Question: Give a one-sentence summary of this figure.
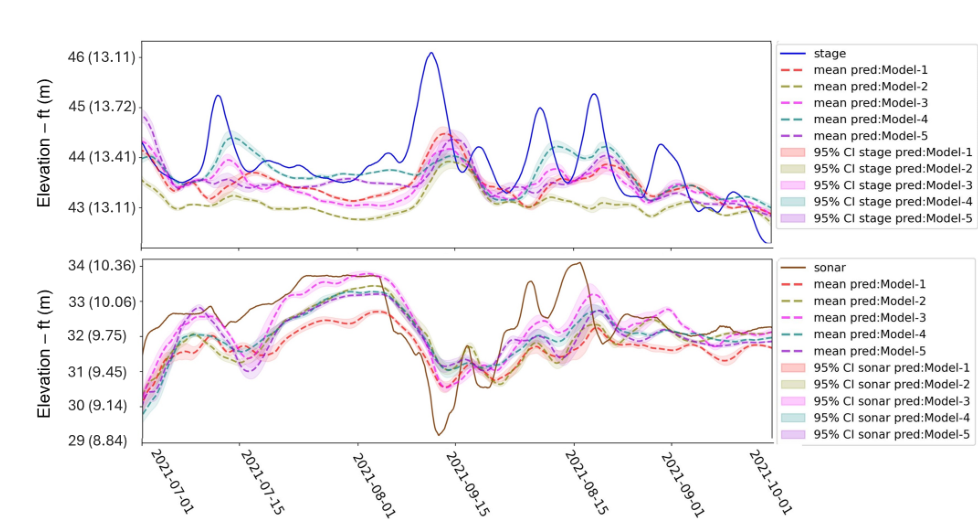
Answer: Stage (top) and Sonar (bottom) predictions of top-5 FCN models selected by the meanMAE policy, mean and 95% confidence intervals over the test dataset - Alaska 230 bridge.